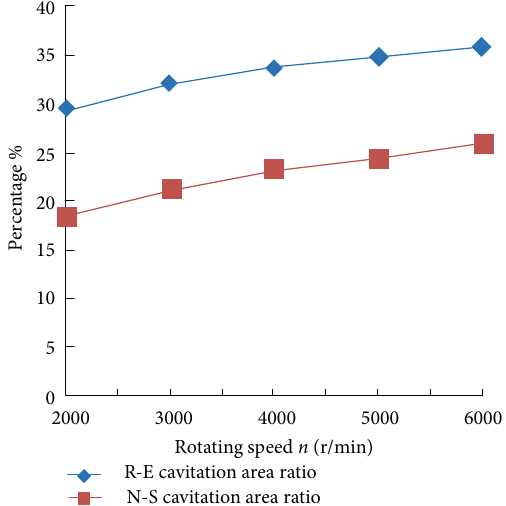
Figure 5: Influence of rotating speed on the area ratio of cavitation.